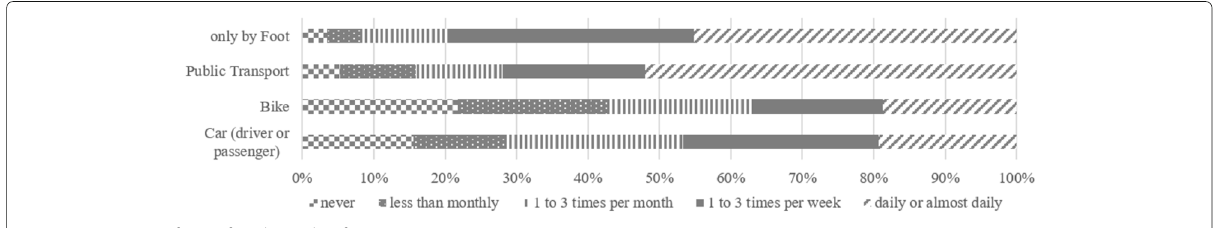
Fig. 4 Frequency of use of each mode of